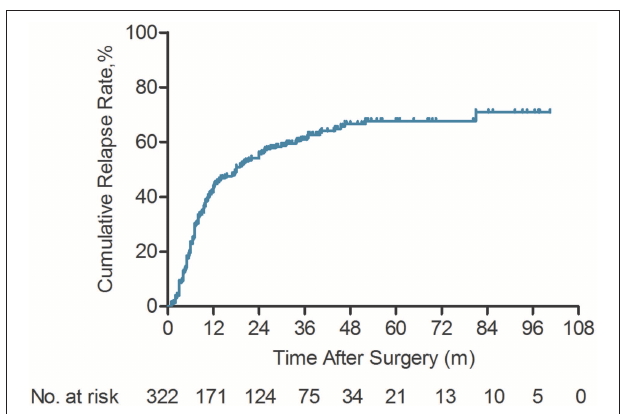
FIGURE 1 | Kaplan-Meier analyses of cumulative relapse rate for intrahepatic cholangiocarcinoma (ICC) patients ( n = 322).